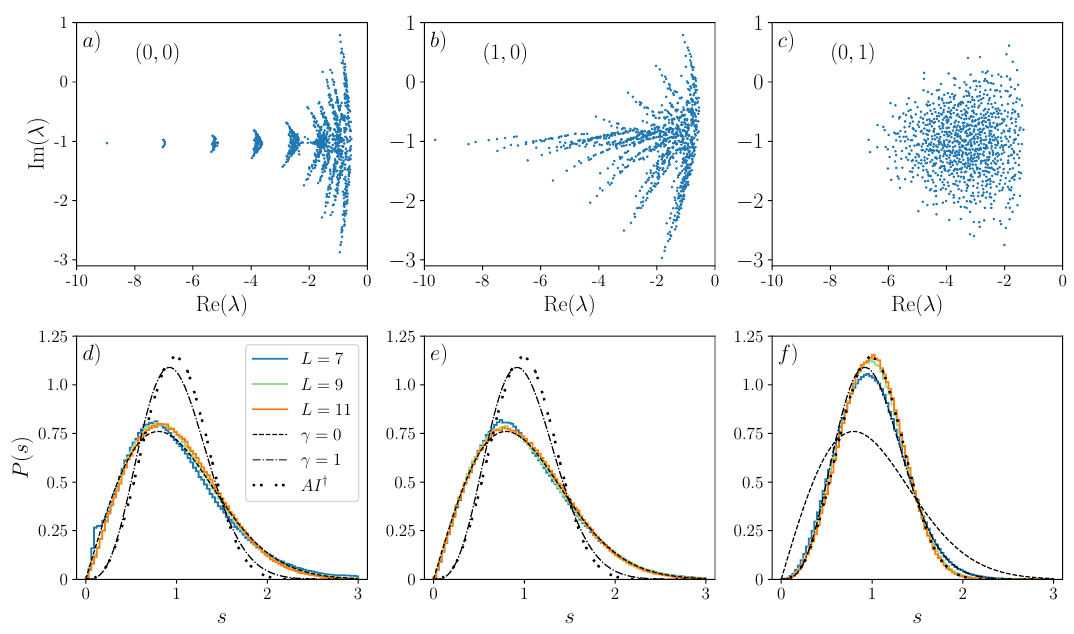
= 1 Figure 1: (a-c) Integrable and chaotic Liouvillian spectra for L = 6, K z = 1, k i in the rational constant (a), rational separable (b) and chaotic (c) Liouvillian limits. (d-f) Level spacing distribution P ( s ) of the integrable and chaotic Liouvillians for = 1, k = 1 with the same ordering as in (a-c). The different sizes L = 7,9,11 and k i z dashed and dash-dotted lines show the γ = 0 and γ = 1 limits of the interpolation distribution P ( s ; γ ) (19), respectively, while the dotted line shows the level statistics of the AI † universality